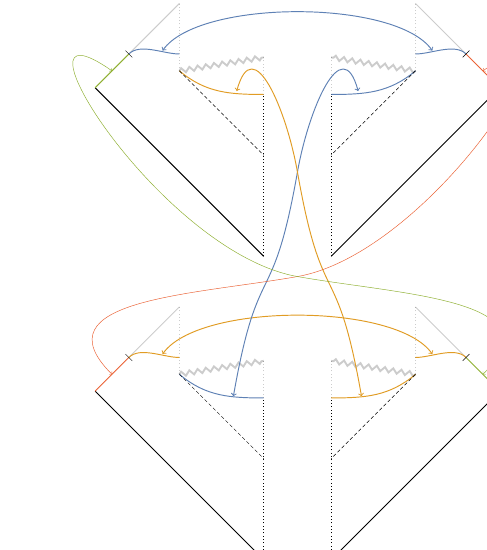
(b) The geometry with swapped interiors gives the second term in (4.11) and (4.12). (cid:0) (cid:1) S ( I u ) ρ (2) , the expec-